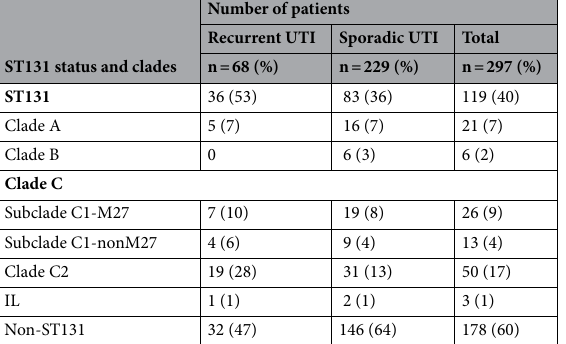
ST131 status and